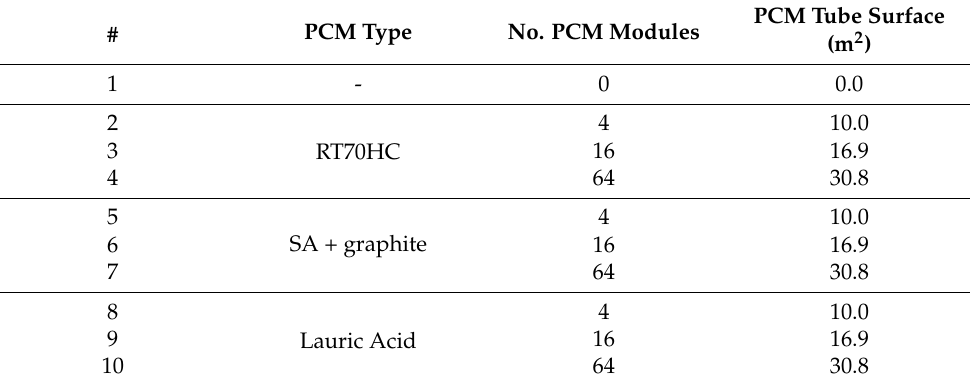
Table 3. Design of experiments to evaluate the effect of the exposed PCM tubes surface area for